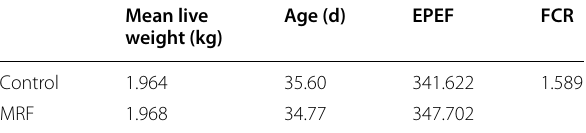
Table 1 Comparison of growth indices of broiler commercial units with and without MRF dietary supplementation Mean live Age (d) EPEF FCR weight (kg)